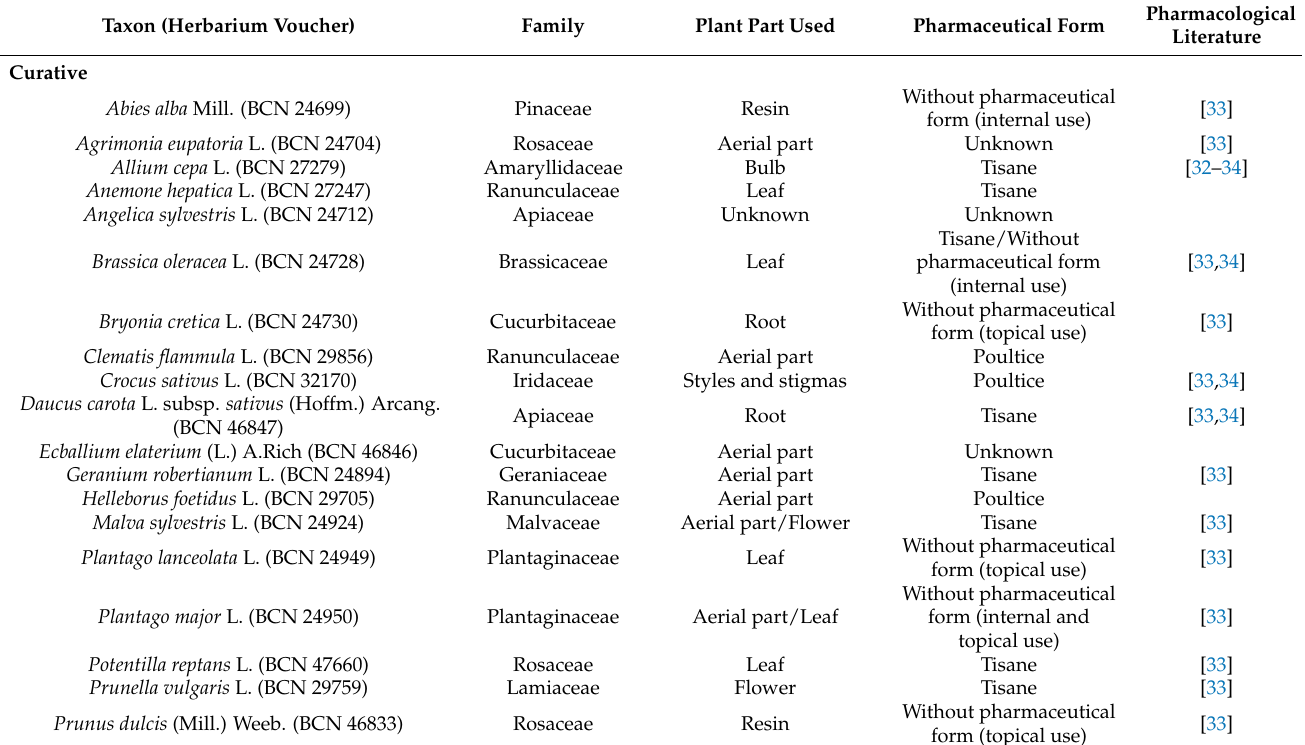
Table 1. Plant taxa used against cancer in the Catalan linguistic area, grouped by curative, palliative, and preventive activities. Comparison of uses in the pharmacological comprehensive literature was extracted from: European Medicines Agency (EMA) monographs [32], Duke’s CRC Handbook of Medicinal Herbs [33], and Fitoterapia.net webpage